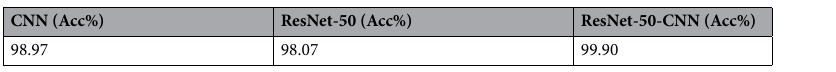
Table 5. Accuracy of CNN, ResNet-50 and ResNet-50-CNN on augmented